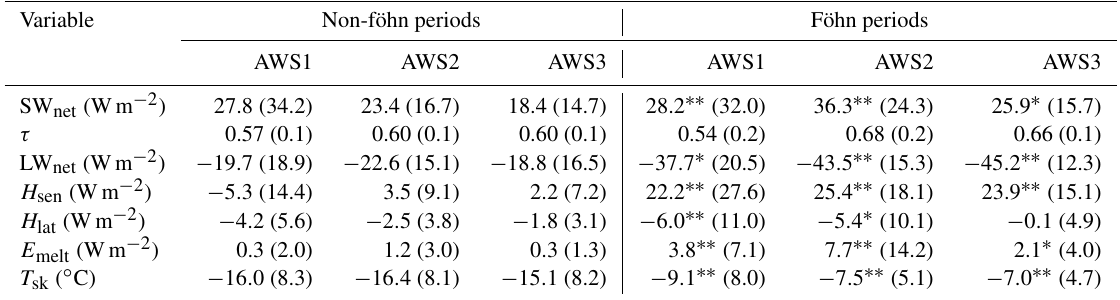
Table 4. Spring daily averages of surface temperature and SEB components for föhn and non-föhn conditions. In brackets are the standard deviations for each